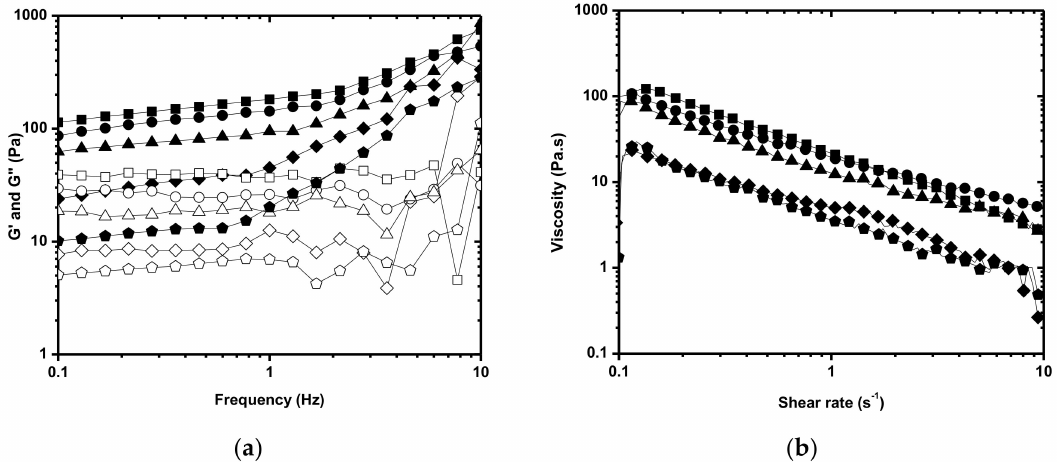
Figure 3. Rheological behavior of the A P-PRP / MP AHA and A P-PRP / MP AHA-CHT (200 µ L of A P-PRP:200 mg of MP AHA or MP AHA-CHT). ( a ) Oscillation spectrum and ( b ) Flow curve. ( ) A P-PRP, ( (cid:7) ) A P-PRP / MP AHA, ( (cid:78) ) A P-PRP / MP AHA-CHT 90:10 , ( (cid:8) ) A P-PRP / MP AHA-CHT 75:25 , and ( (cid:4) ) A P-PRP / MP AHA-CHT 50:50 . G’ (closed symbol), G” (open